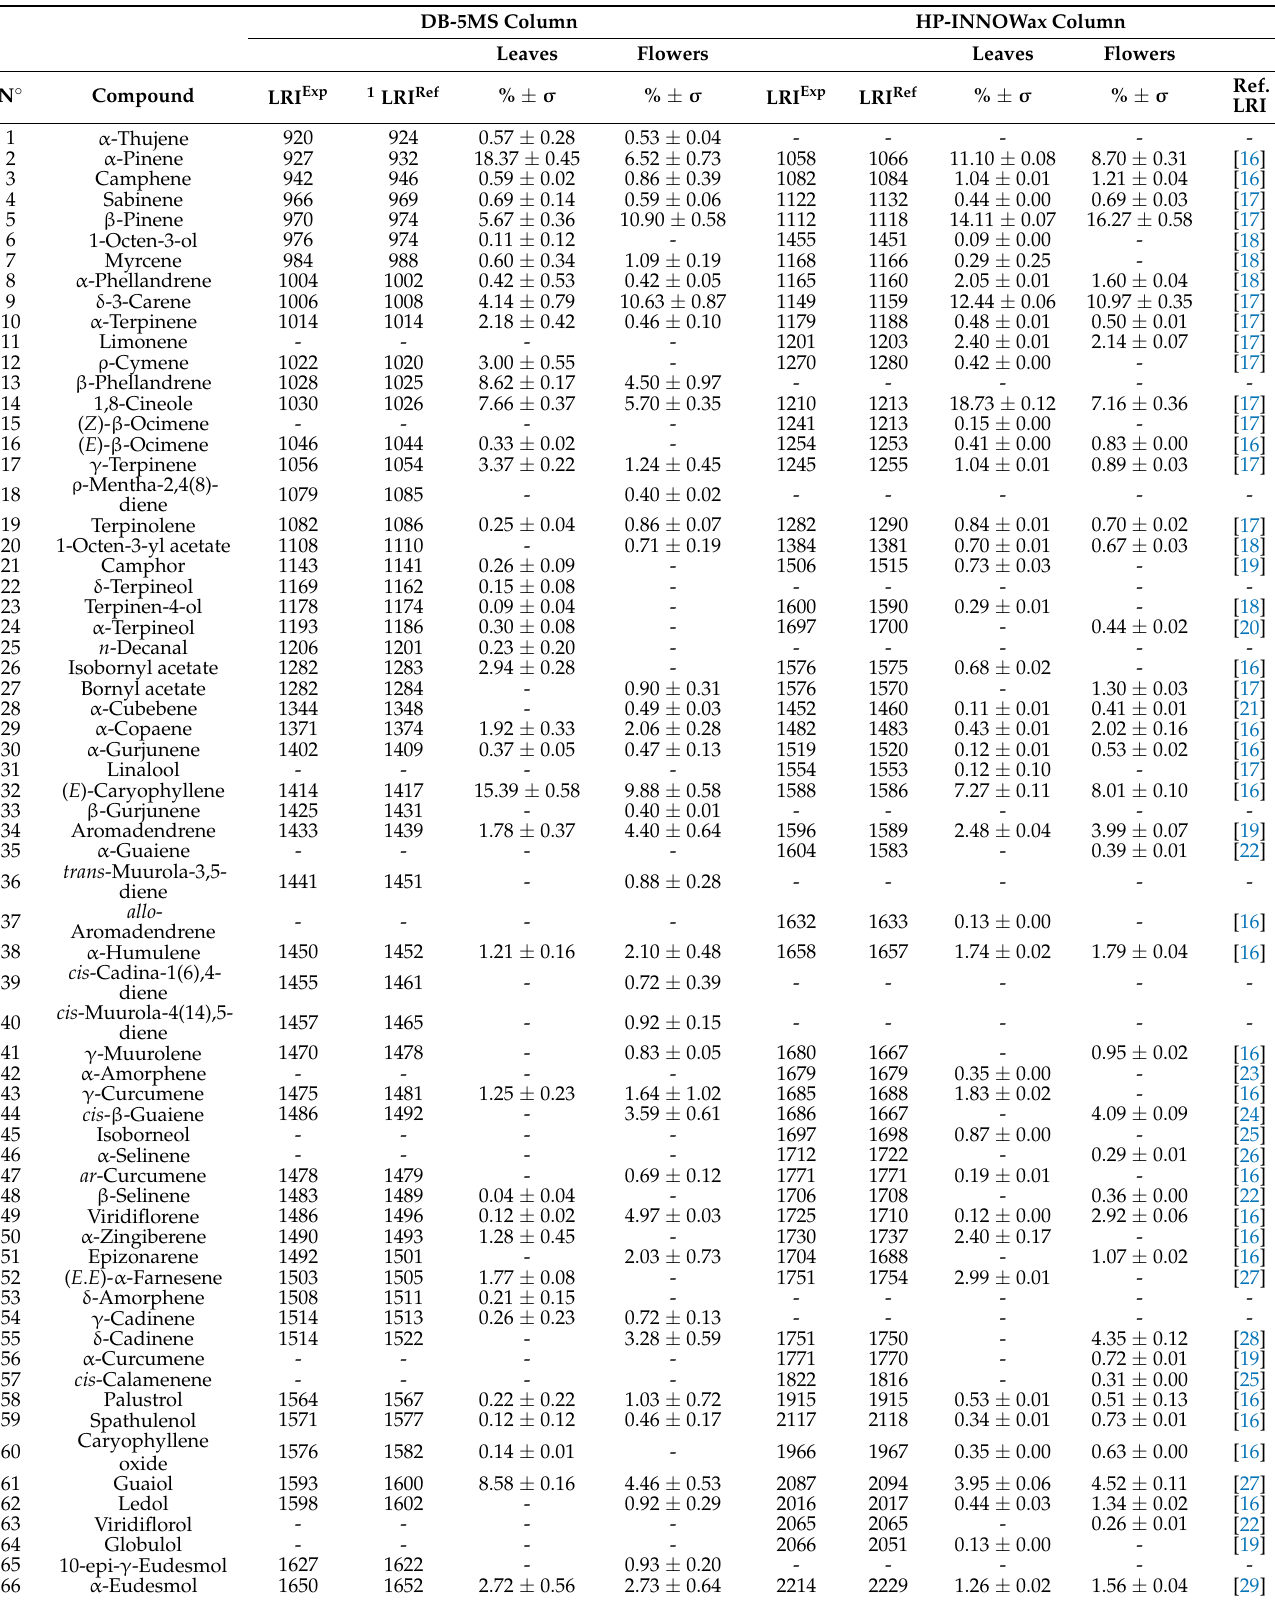
Table 1. Chemical composition of the leaves and flowers of Lepechinia paniculata essential